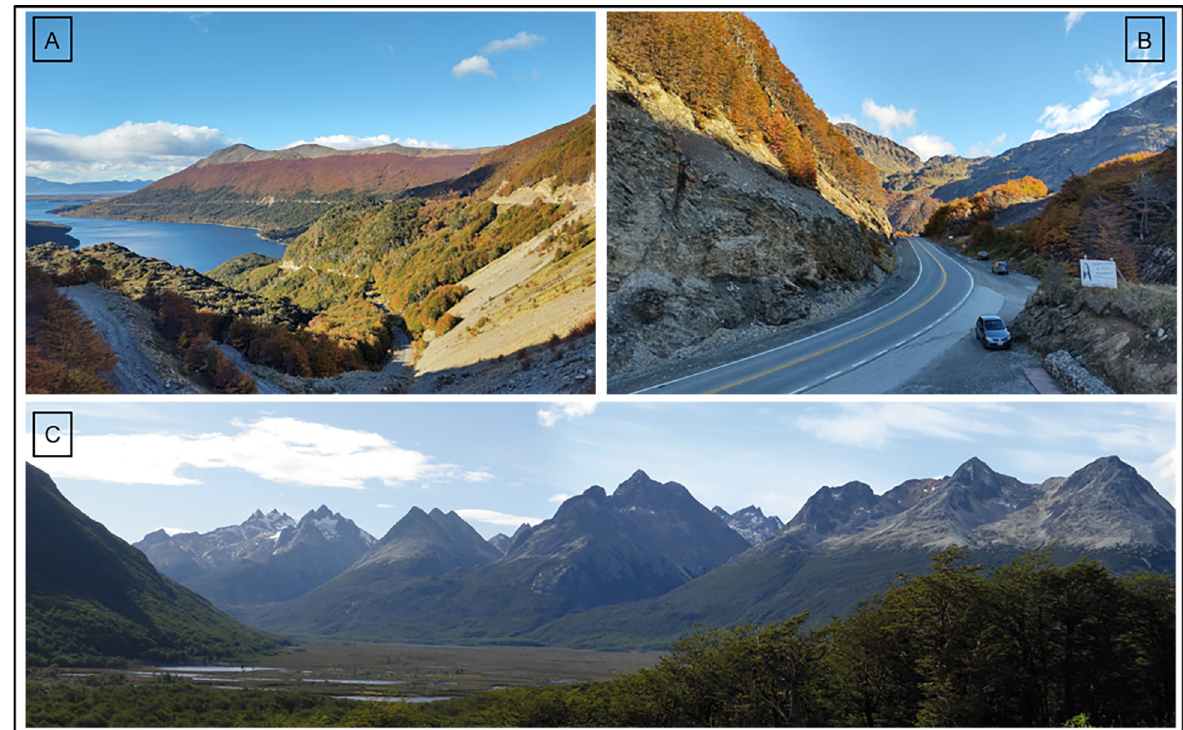
Fig. 8. Erosional features in the Fuegian Andes. view from the col of the lateral glacial valleys developed to the N; A – Escondido lake valley and to the S, B – Rancho Hambre valley. C – Carbajal trough showing aretes, horns, cirques, cirque glaciers and neves, hanging valleys, truncated spurs sculptured on Alvear range, on the northern side of the valley; the wide bottom of the trough is covered by Sphagnum magellanicum peat bogs and ponds. The tree-line is at 650 m